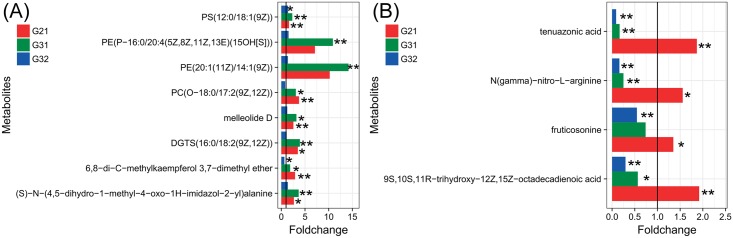
Bar plots of the significantly altered concentration ratio of the same metabolite compared among mycelium groups.(A): Metabolites with increased concentrations in both mature groups. (B): Metabolites with increased concentrations in the undifferentiated group but decreased concentrations in the differentiated group. G21: Each value represents the ratio of the average concentration of a given metabolite in group 2 divided by the average concentration of the same metabolite in group 1. G31 and G32: Each value represents the ratio of the average concentration of a given metabolite in group 3 divided by the average concentration of the same metabolite in groups 1 and 2, respectively. **: p-value < 0.01. *: p-value < 0.05. The black vertical line indicates a fold change equal to 1.